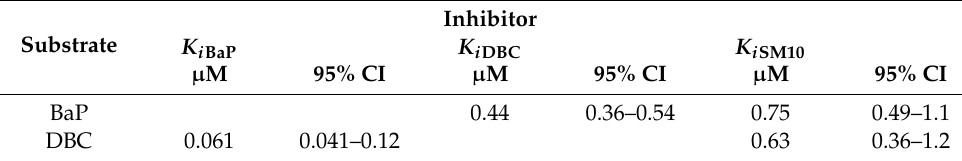
Table 4. Inhibition constants ( K i ) with 95% confidence intervals (CI) of competitive inhibitors to benzo[a]pyrene (BaP) and dibenzo[def,p]chrysene (DBC) metabolism in human hepatic micro ‐ somes. Inhibitors included BaP, DBC, and Supermix ‐ 10 (SM10).